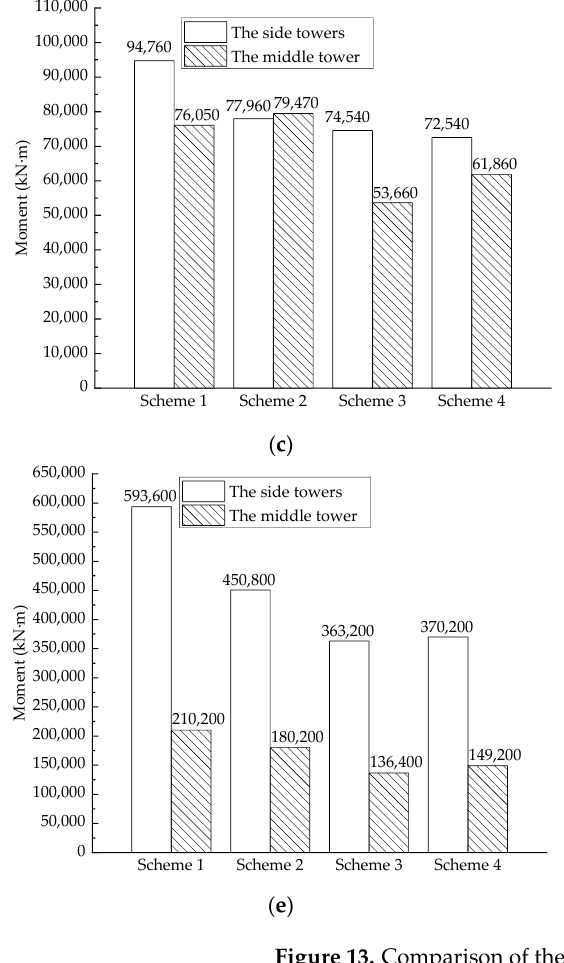
Figure 13. Comparison of the longitudinal tower shaft moment with different layout schemes of the viscous dampers. ( a ) San Fernando Pacoima Dam record; ( b ) Whittier Narrows-01 record; ( c ) Taft Lincoln School record; ( d ) El Centro Site record; ( e ) MtCarmel-2008-0418a record.